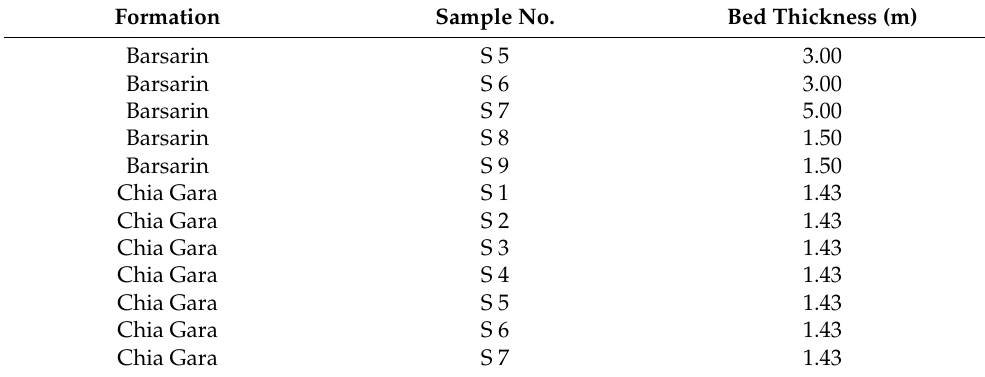
Table 1. Cont. Formation Sample No. Bed Thickness (m) Barsarin S 5